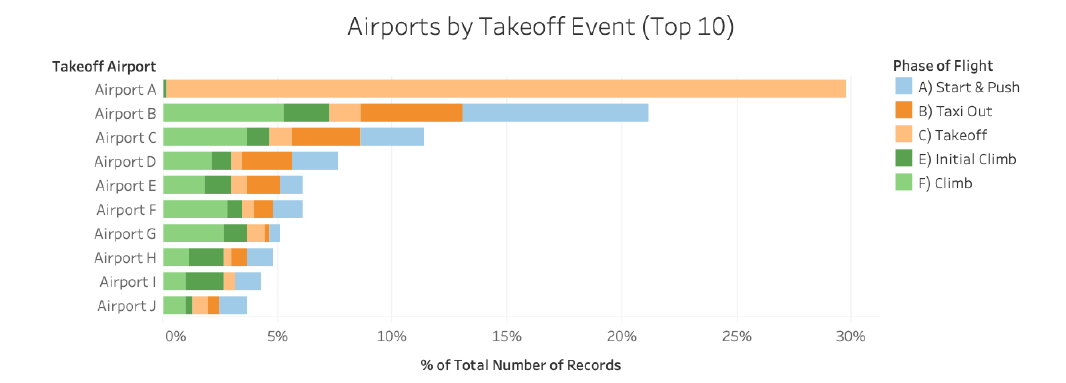
Figure 4. Location-based analysis showing the relative distribution of takeoff events by airport of